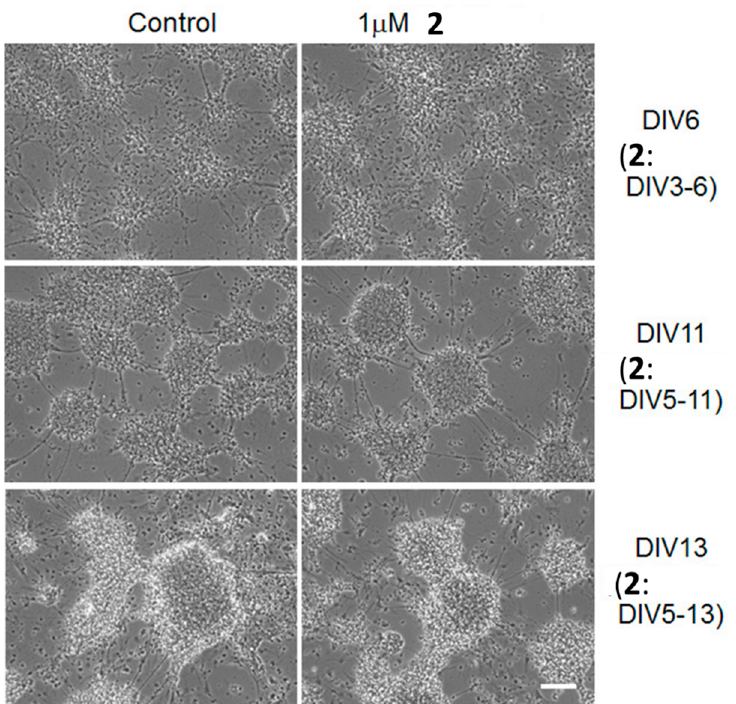
Figure 5. Micrographs of cultures of mouse embryonal neuronal cells untreated (control) or treated with 1 µM of 2 ; DIV, days in vitro. Scale bar: 100 µm.